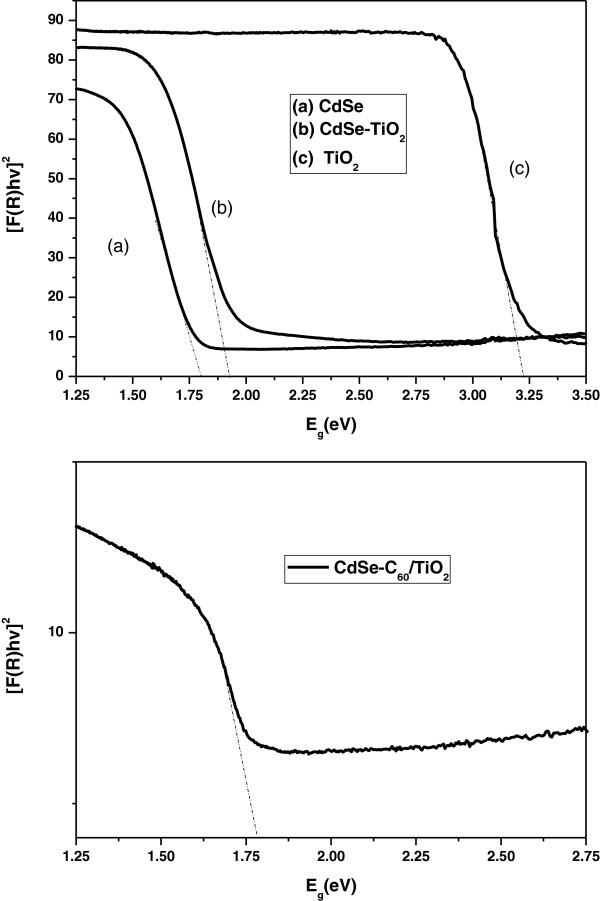
Variation of (αhν)2 versus photon energy (hν) for CdSe, CdSe-TiO2, TiO2, and CdSe-C60/TiO2.